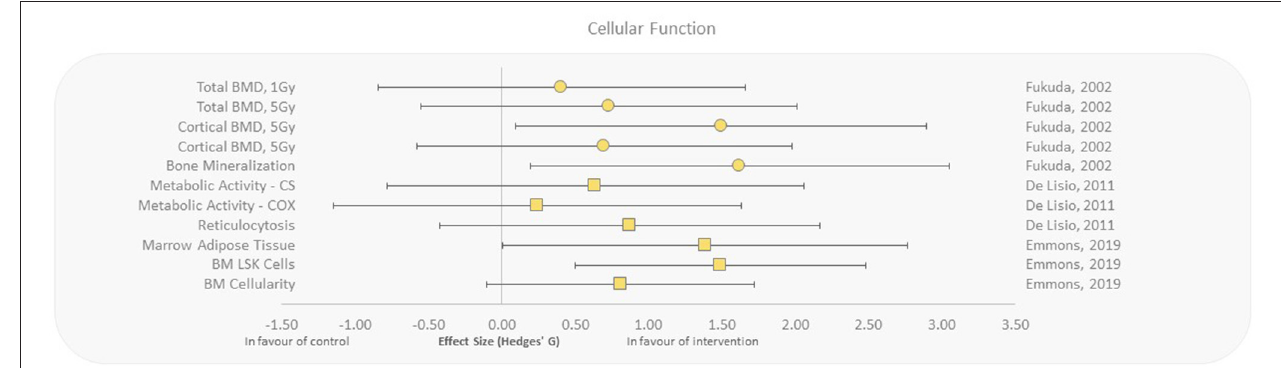
FIGURE 6 | Effect size plot of cellular and tissue function in animal studies. Outcomes are plotted with the Hedges’ g calculated for each outcome extracted and bias corrected for sample size. Confidence intervals of 95% are represented by the error bars. Effect size values that are in the positive rightward direction indicate a beneficial effect in favor of the exercise intervention group compared to the non-exercise control group. Shapes refer to the time at which the exercise intervention was applied with respect to the radiation exposure (Post—Circle,